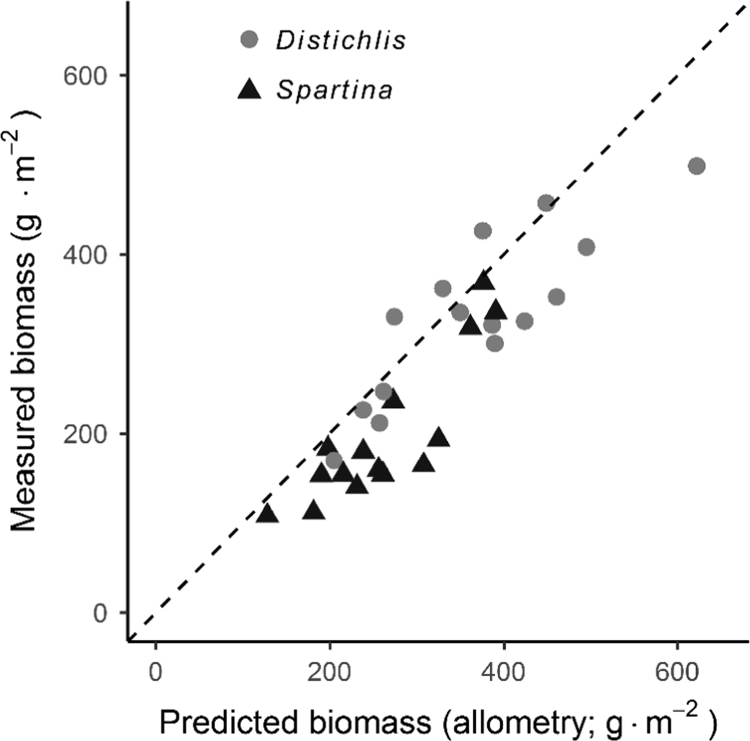
Relationship between allometry-based biomass estimates and biomass measured at harvest for each mesocosm (R2 = 0.80, y = 0.87x, P < 0.001), with dashed 1:1 line shown.